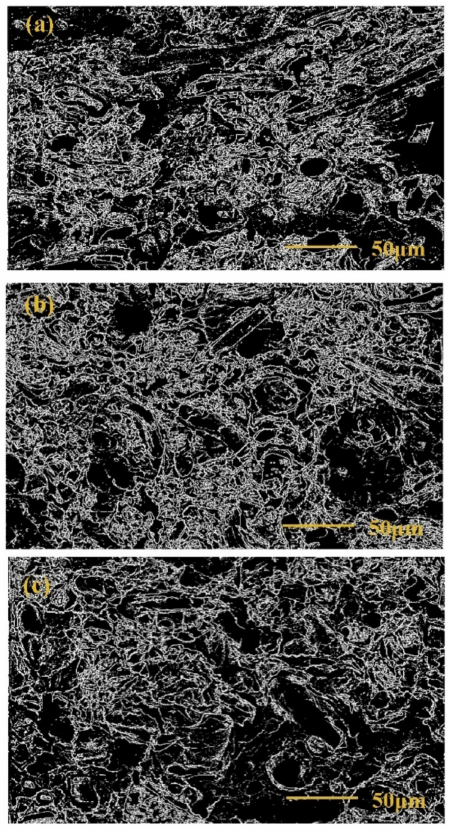
Figure 8. Binary pictures of composites fracture surface for EMP ( a ), IMP ( b ), and HPMP ( c